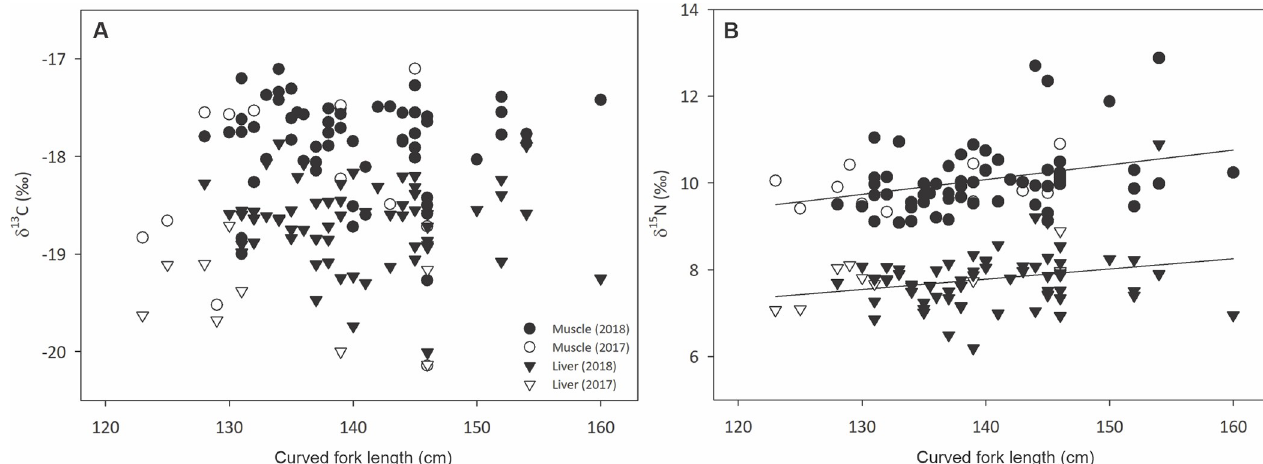
Fig 3. Relationship between YFT curved fork length and bulk δ 13 C and δ 15 N values of muscle and liver tissues. (A) YFT curved fork length in cm vs. bulk δ 13 C values of muscle and liver tissue. (B) δ 15 N values of muscle and liver tissue; solid lines indicate a significant linear relationship between curved fork length and δ 15 N values in muscle (r = 0.34, p = 0.003) and liver (r = 0.03, p =